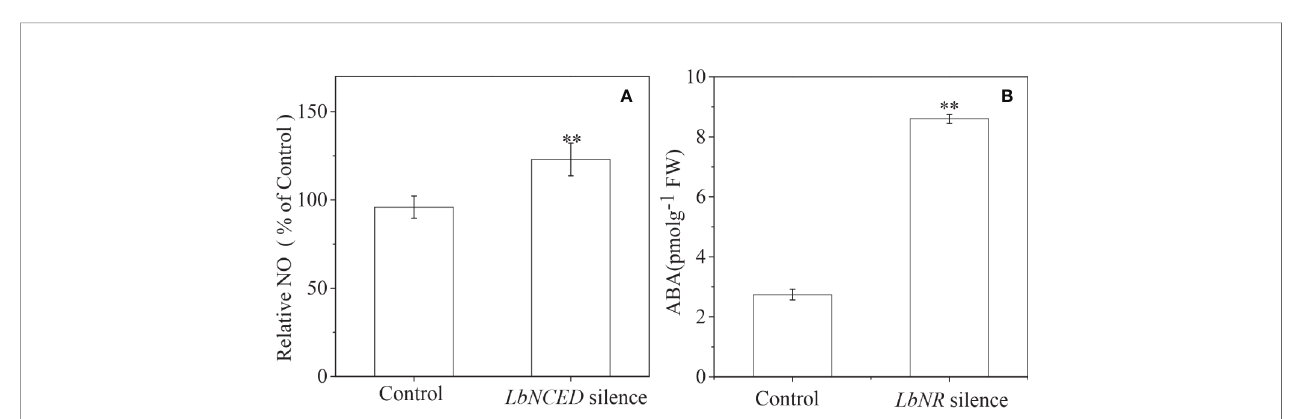
FIGURE 9 | Effect of LbNR silencing or LbNCED1 silencing on ABA accumulation and NO release of L . ruthenicum fruits, respectively. ABA was assayed by an immunoassay method as described in the section of “ Materials and Methods ” , and NO was determined as described in Figure 2 . The error bars represent the SDs of three independent replicates. The asterisks on the bars for the same species indicate signi fi cant differences between the treatments (p <